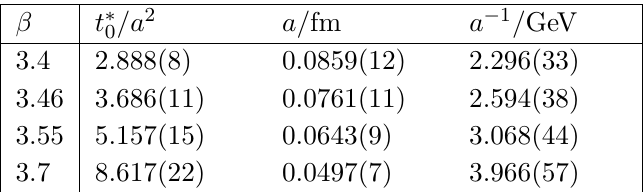
Table 2. The values of t ∗ /a 2 and the lattice spacings employed in this study, as determined in [47]. 0 The lattice spacings were obtained using (8 t ph ) − 1 / 2 ≈ 0 . 475(6) GeV [44]. 0